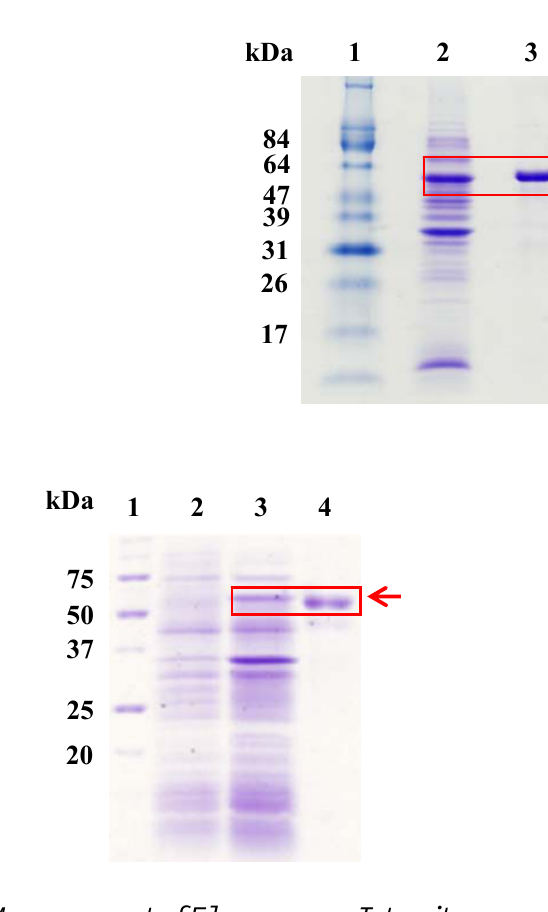
Figure 3. Expression analysis of fluobody by SDS-PAGE. ( a ) SDS-PAGE analysis of C- and N-fluobody/PL. Lane 1; molecular protein marker, lane 2; C-fluobody in insoluble fraction after IPTG induction, lane 3; C-fluobody/PL after IMAC purification (1.5 µg), lane 4; N-fluobody in insoluble fraction after IPTG induction, lane 5; N-fluobody/PL after IMAC purification (1.5 µg). ( b ) SDS-PAGE analysis of C- and N-fluobody/G-Re. lane 1 and 5; molecular protein marker, lane 2 and 6; total proteins before IPTG induction, lane 3; C-fluobody/G-Re in insoluble fraction after IPTG induction, lane 4; C-fluobody/G-Re after IMAC purification (2.1 µg), lane 7; N-fluobody/G-Re in insoluble fraction after IPTG induction, lane 8; N-fluobody/G-Re after IMAC purification (2.1